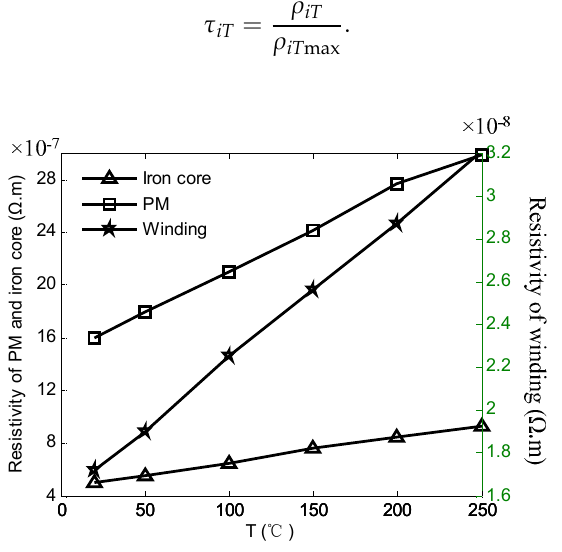
Figure 3. The resistivity curve changes with temperature.